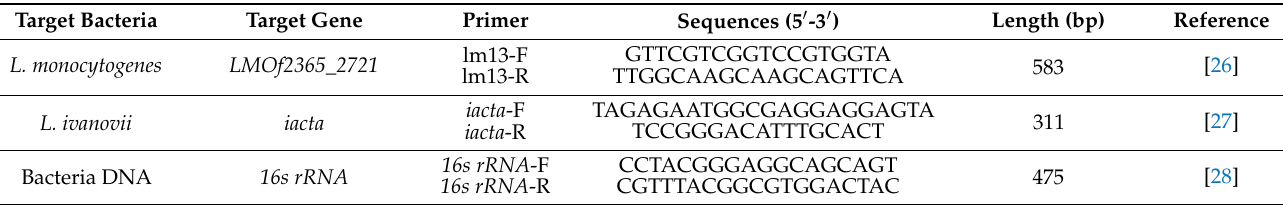
Table 1. Primers used in the mPCR assay 1 .